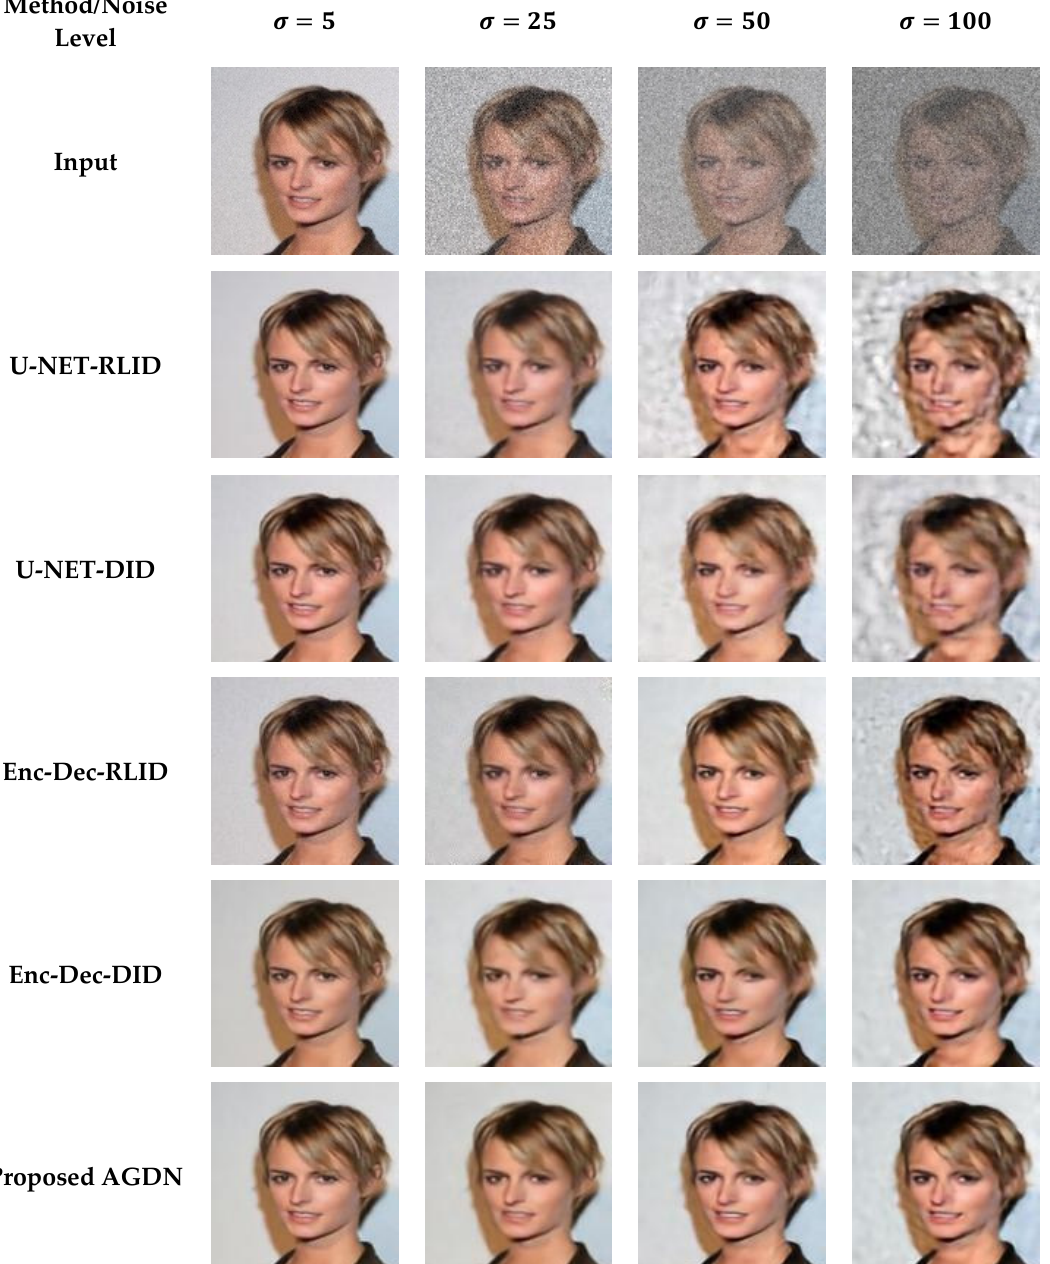
Figure 6. Sample results of the image denoising task using different methods and network structures. The first row is the input images of different noise levels. The second row shows the results produced by the RLID method using the U-NET structure. The third row presents the U-NET structure results via the DID method. The fourth row shows the encoder-decoder structure results using the RLID method. The fifth row presents the encoder-decoder structure results via the DID method. The sixth row demonstrates the results of the proposed AGDN.